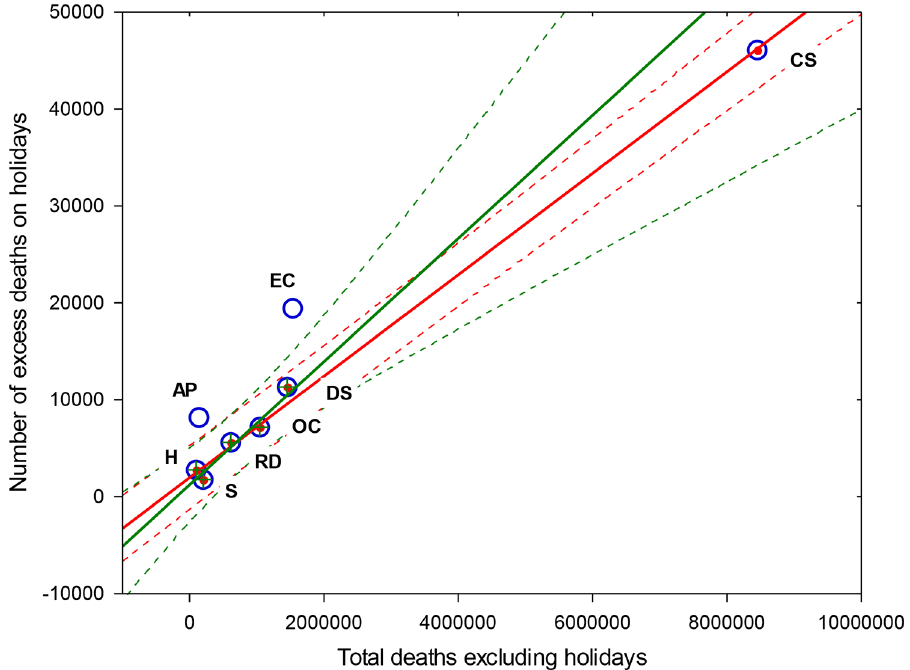
Fig. 6. Ratio of excess and total mortality for certain classes of causes of death. Note: CS — diseases of the circulatory system, RD — diseases of the respiratory system, DS — diseases of the digestive system, EC — all external causes, AP — alcohol poisoning, H — homicides, S — suicides, OC — other exter- nal causes. Blue circles in the diagram indicate all eight classes of causes of death, red dots indicate a set of causes without EC and AP (red regression line), crosses — a set of causes without CS, EC, and AP (green regression line). The dotted lines represent the 95% confidence intervals. Source: authors’ calculations based on modelling and Rosstat